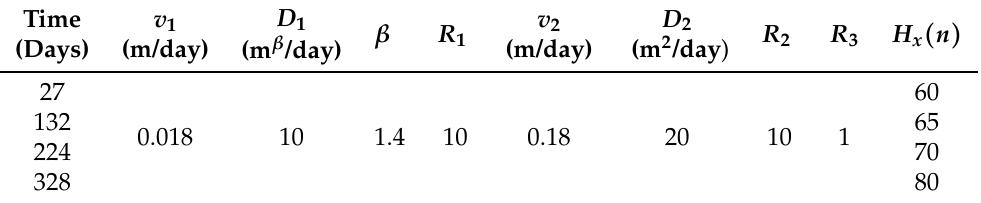
Figure 6. Comparison between the documented snapshots (symbols) and the best-fit results using the ADE (1) and PDDO-based (9) models at four times ( t = 27, 132, 224, and 328 days) along the 300 m-long heterogeneous media. The weight function set as k = 2 for Equation (24), and the horizon set as H x = n ∆ x . ( a ) 27 days, ( b ) 132 days, ( c ) 224 days, and ( d ) 328 days. · Table 1. The best-fit parameters for F-ADE ( v 1 , D 1 , R 1 , β ), ADE ( v 2 , D 2 , R 2 ) and PDDO-based ( v 2 , D 2 , R 3 , H x )